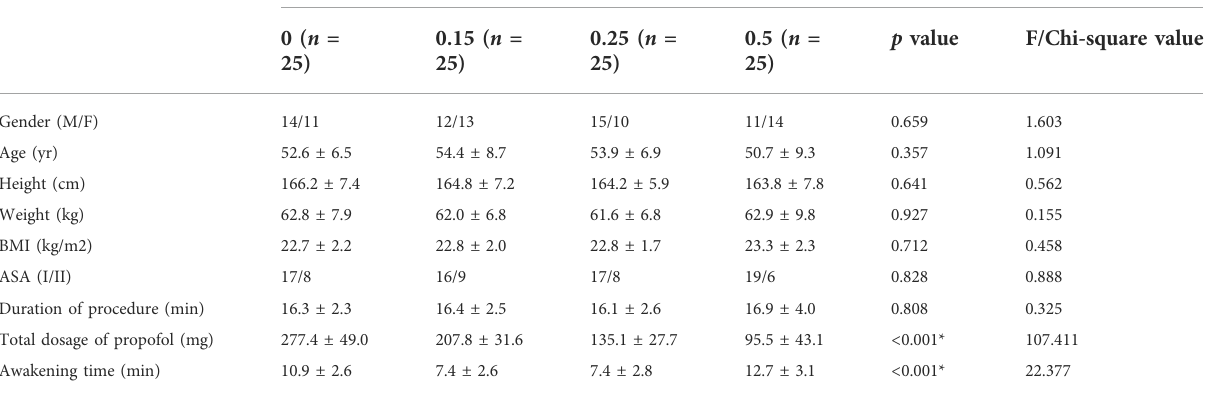
TABLE 2 Patient